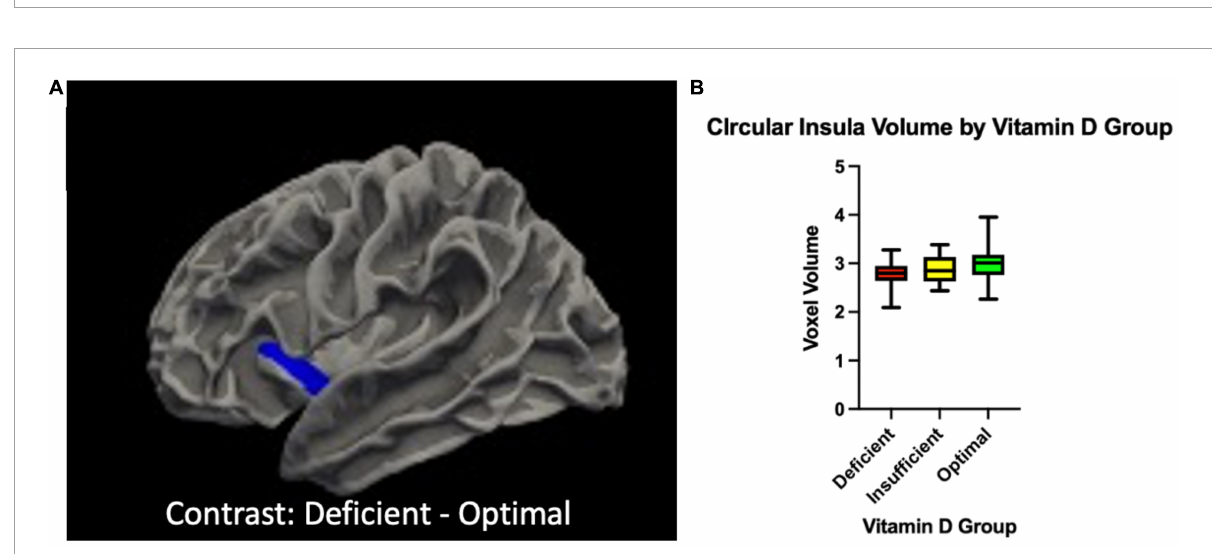
FIGURE2 (A) The volume of in a cortical cluster overlapping with inferior segment of the left circular sulcus of the insula {region of the Destrieux atlas [FreeSurfer aparc.a2009s (Destrieux et al., 2010)] containing the maximum T-statistics} was higher for individuals with deficient Vitamin D levels compared to those with optimal levels. To ease visual interpretation, we have used blue to represent the significant positive “Deficient – Optimal” contrast. (B) Box-plots depicting the distribution of the cortical thickness in the cortical vertex where the T-statistics of this group comparison was maximum for each Vitamin D level